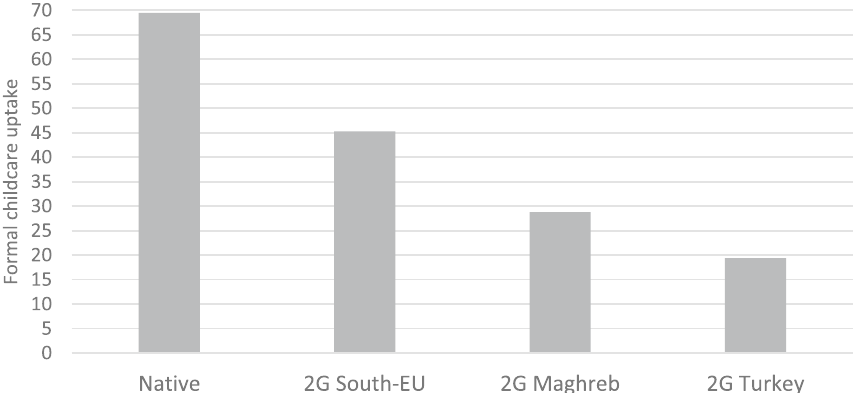
Fig. 3 Formal childcare uptake by mothers’ origin group among two-parent households with one child aged 0-2.5 years (Source: Belgian Census 2011 linked to longitudinal register data, longitudinal tax return data on childcare expenses and municipality-level data on childcare coverage from K&G and ONE. Calculations by